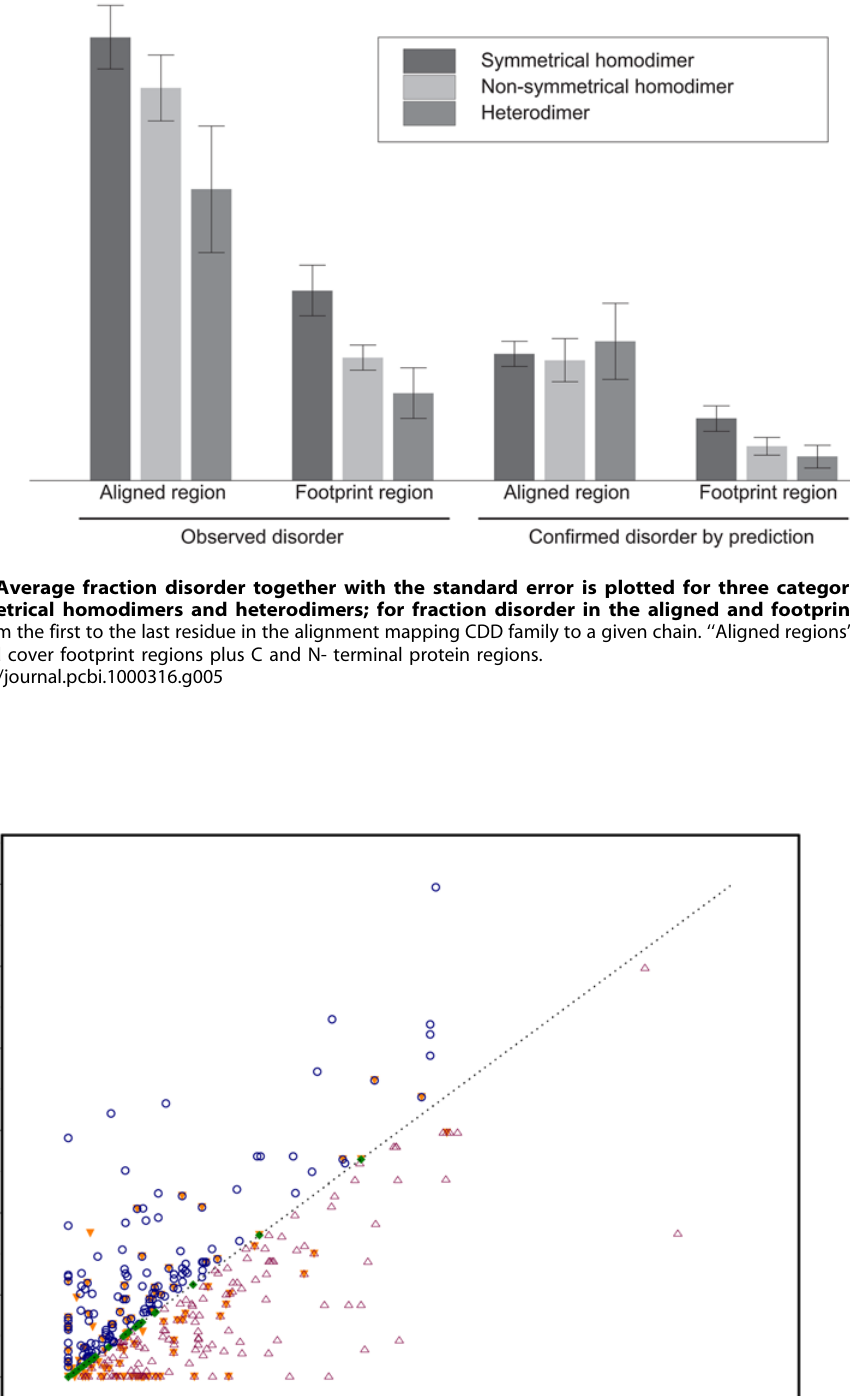
PLoS Computational Biology |